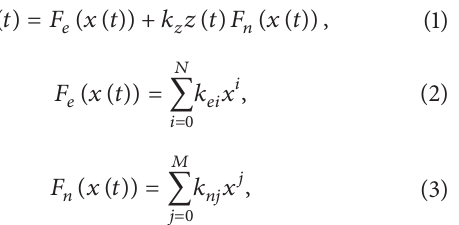
Figure 14: The selected “bounded region” of a measured hysteresis